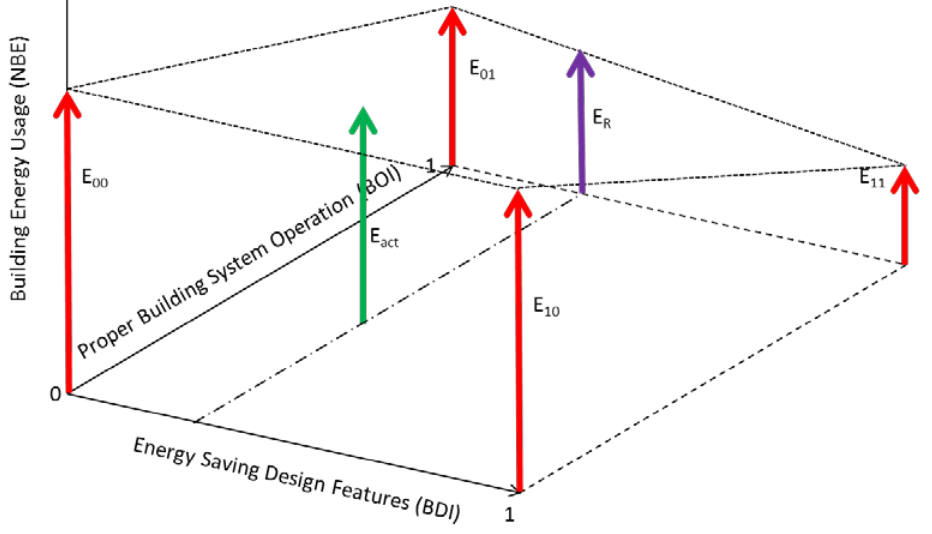
Figure 3. Building Energy Usage as a function of design and operation